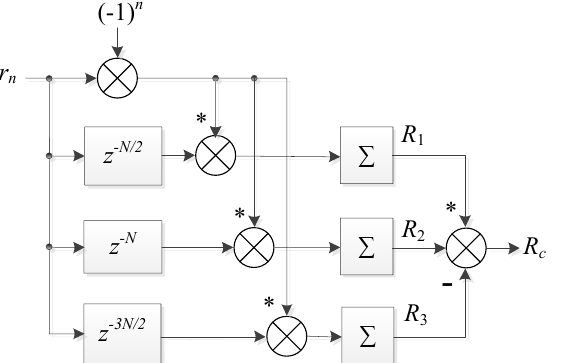
Figure 3. Proposed time–domain sliding auto-correlation module for timing and carrier frequency